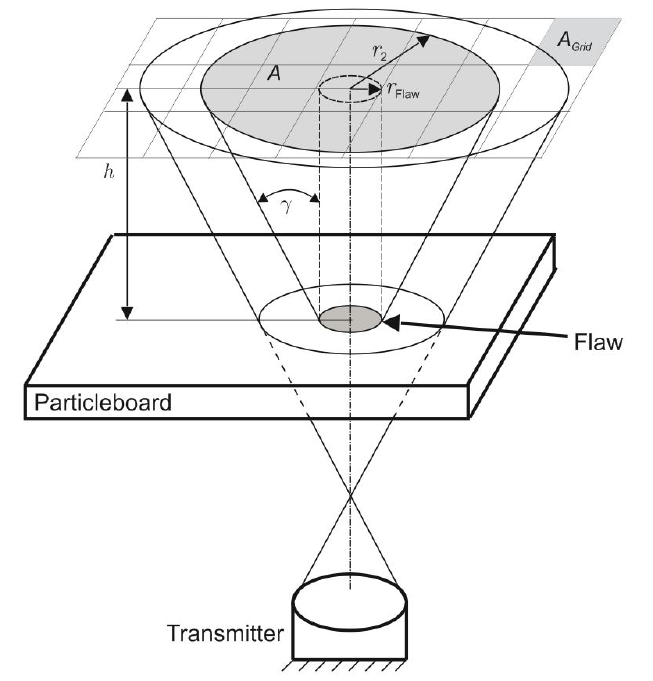
Figure 15. Schematic representation of the sound fields and the measuring